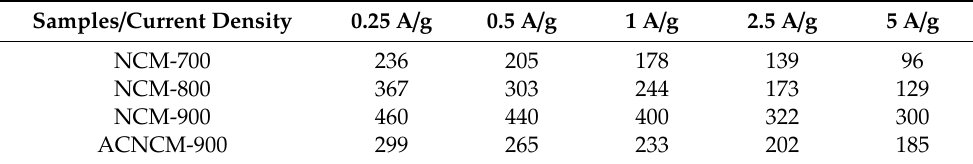
Table 3. The specific capacitance (F / g) of carbon materials at di ff erent current densities. Samples / Current